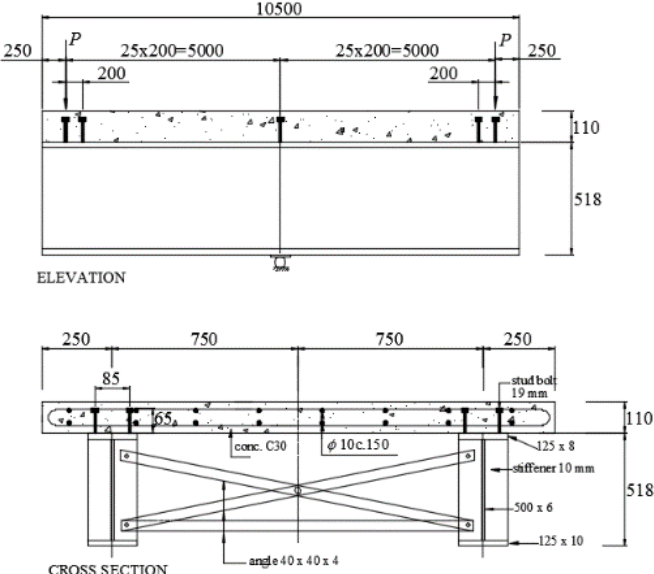
Figure 2. Elevation and cross section of prototype U4 at the support (dimensions in millimeter)